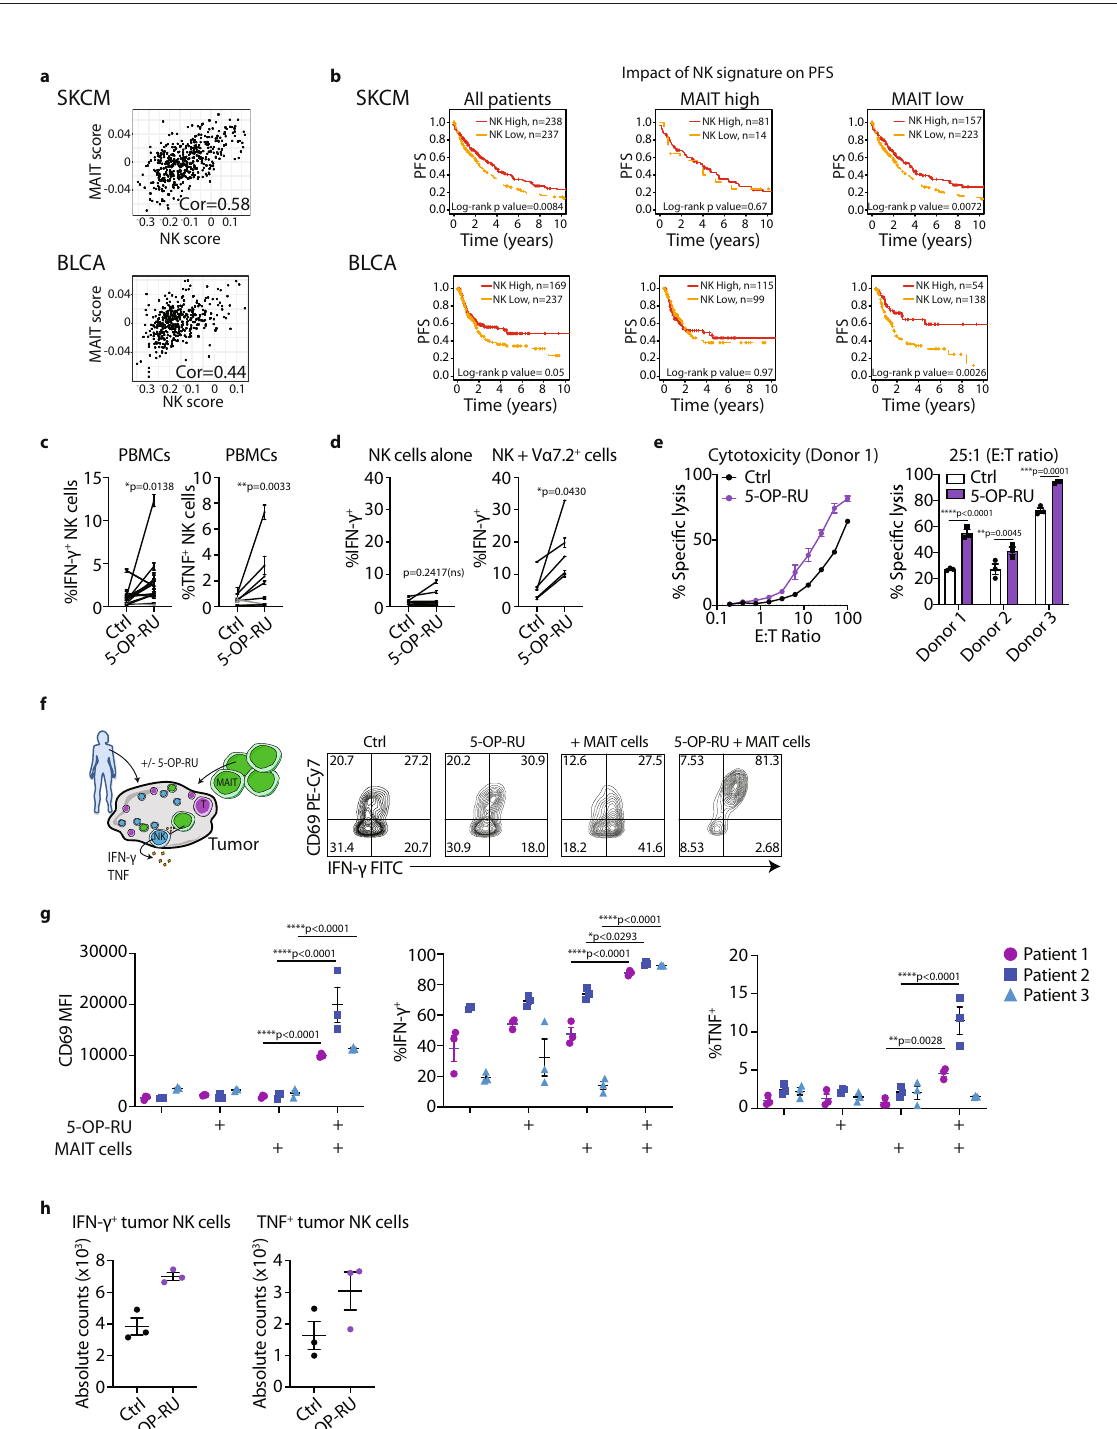
Fig. 5 MAIT cell-mediated enhancement of NK cell anti-tumor function is IFN- γ dependent. a , b B6-MAIT cast MR1 WT mice were treated as per Fig. 3a. 5 × 10 5 B16F10 cells or PBS control were injected i.v. at day 6 and 12 h later lungs were processed. NK1.1 + NK cells were FACS sorted and RNA extracted for subsequent 3 ′ RNA-sequencing analysis. Cells were harvested from three mice per group and data represented as technical duplicates. Heatmaps show relative expression of genes in indicated pathways. a Differentially expressed genes were subject to hallmark pathway analysis. Indicated signatures were signi fi cantly upregulated post intranasal 5-OP-RU treatment. b Heatmaps showing expression of indicated genes in pathways identi fi ed. c B6-MAIT cast MR1 WT mice were treated as per Fig. 3a. Expression of IFN- γ and TNF from MAIT cells at indicated days post 5-OP-RU expansion. Data is presented as mean ± SEM of n = 5 independent mice per group from one independent experiment, one-way ANOVA. d C57BL/6 mice were treated as per Fig. 3a, inoculated with 2 × 10 5 B16F10 cells and received 250 μ g of anti-IFN- γ i.p. on day 0 and 1. Data is presented as mean ± SEM of n = 11 (non-treated and 5-OP-RU treated) and n = 10 (5-OP-RU + α IFN- γ treated) independent mice, from two combined experiments, one-way ANOVA. e Heatmaps showing expression of indicated genes in pathways identi fi ed from Fig. 5b. * p < 0.05, ** p < 0.01, **** p < 0.0001, ns = non-signi fi